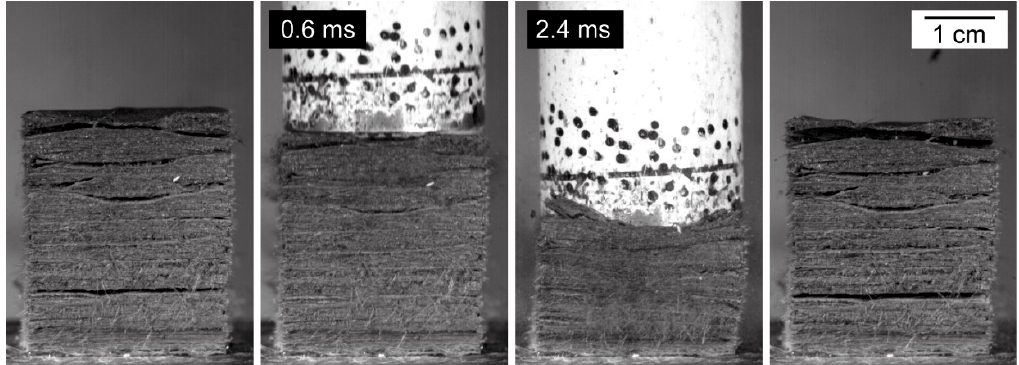
Figure 6. Images extracted from a high-speed video of a dynamic drop-weight test of S. giganteum bark, revealing its nonuniform compaction behavior. From left to right: bark sample before impact, bark sample 0.6 ms and 2.4 ms after first contact with the impactor, bark sample after impact test.